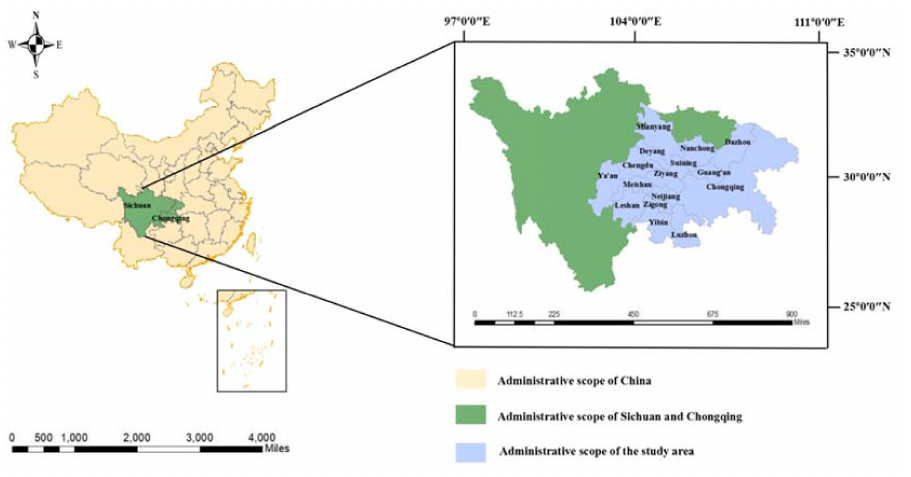
Figure 1. Location of the study area.